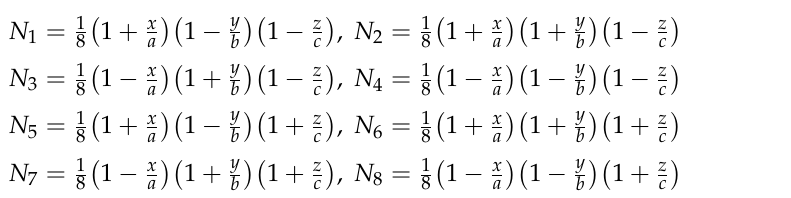
Figure 3. Flow chart of multi-scale fatigue analysis method for ceramic matrix composites based on dynamic sub-model.